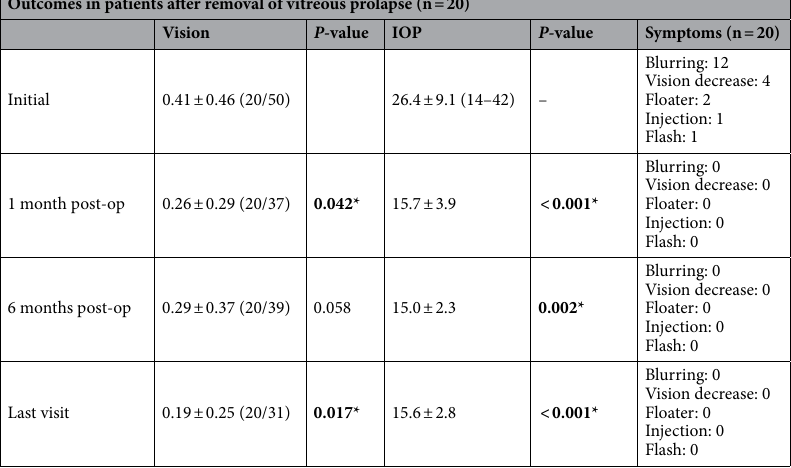
Table 3. Outcomes in patients after removal of vitreous prolapse. Average post-operative follow-up duration: 48 months. Values displayed as mean ± SD. Visual outcomes compared to initial visual acuity. Two-sample paired t tests. A P -value less than 0.05 considered statistically significant. Normality test done using the Kolmogorov–Smirnov test. All groups followed normal distribution ( P > 0.05). FC = 2.00 logMAR, HM = 2.30 logMAR, LP = 2.60 logMAR, no light perception = 2.90. IOP intraocular